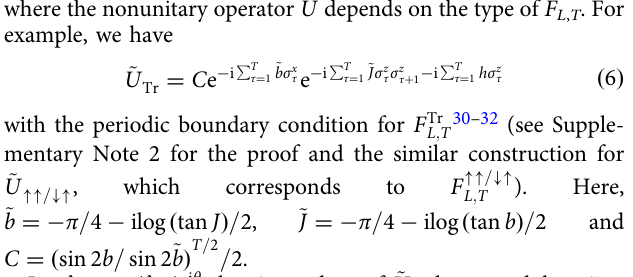
Fig. 2 Dynamical quantum phase transitions (DQPTs) caused by the variation of the rotation angle b . a Dynamical free energy density F Tr whose singularities indicate DQPTs. Among DQPTs, we have the exceptional DQPT (red circle), which shows divergent derivative, and the DQPT crossing the self-dual point (blue circle). b Imaginary part of the generalized expectation value given in Eq. (4), which is proportional to the b -derivative of F Tr . While it exhibits a jump for typical DQPTs, it diverges 1 ; T at the exceptional DQPT. (inset) The divergence obeys ð b c (cid:2) b Þ (cid:2) 1 = 2 (red dashed line). We use J = − π /4 and h = 3.0, and T =